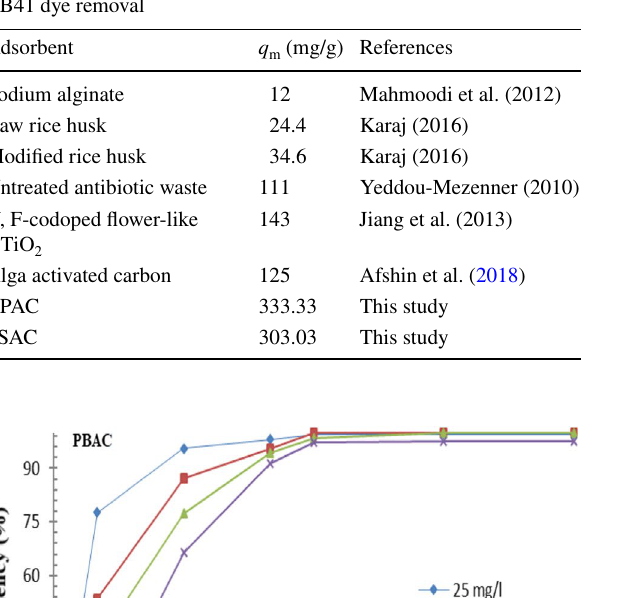
Table 2 Comparison of adsorption capacity of different adsorbents in